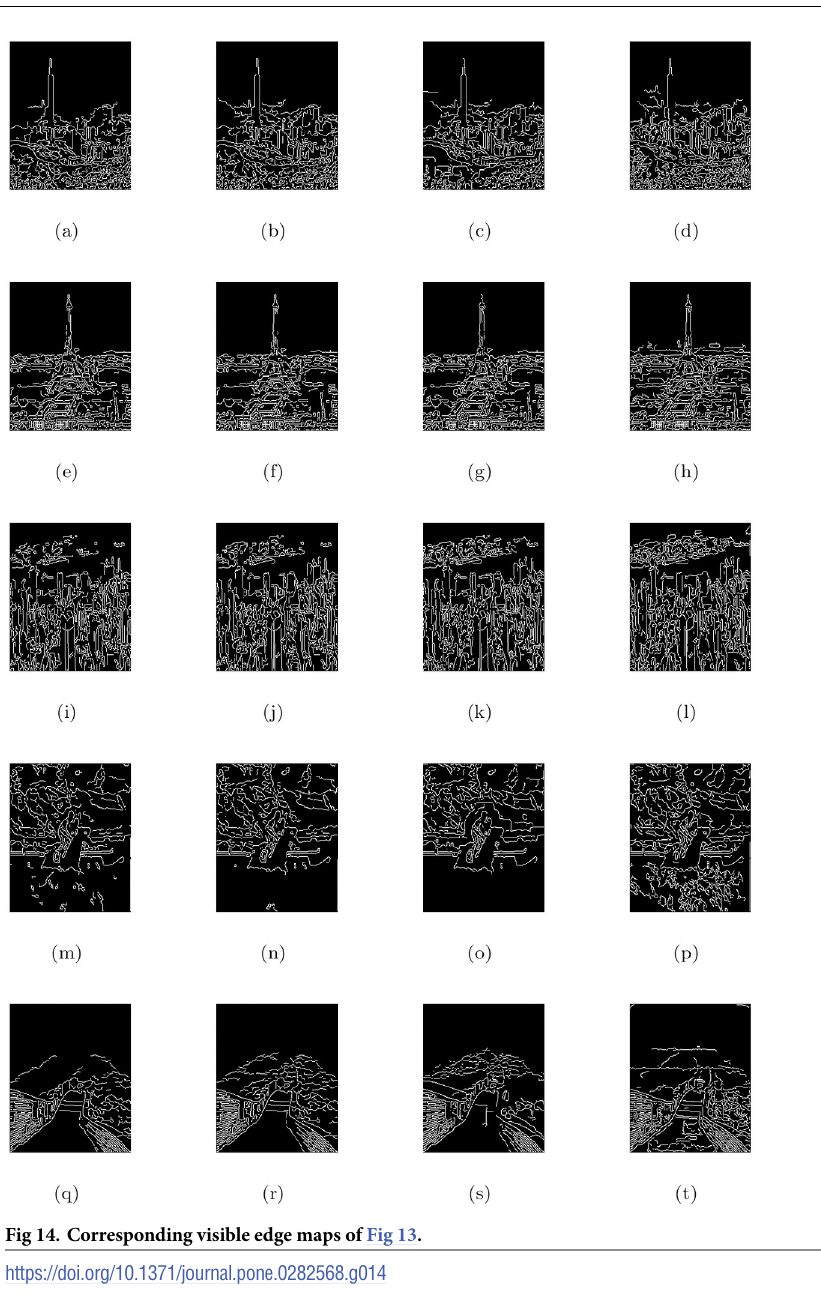
Fig 14. Corresponding visible edge maps of Fig 13.